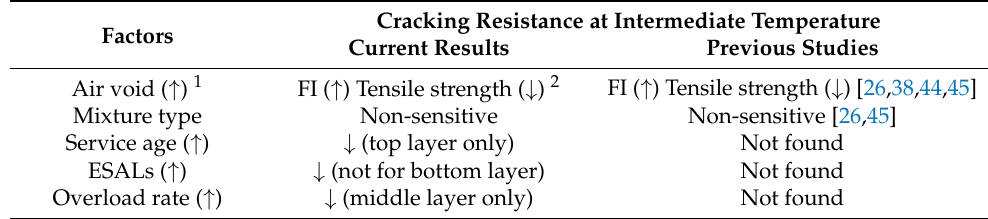
Table 6. Comparison of effects of factors on cracking resistance with previous